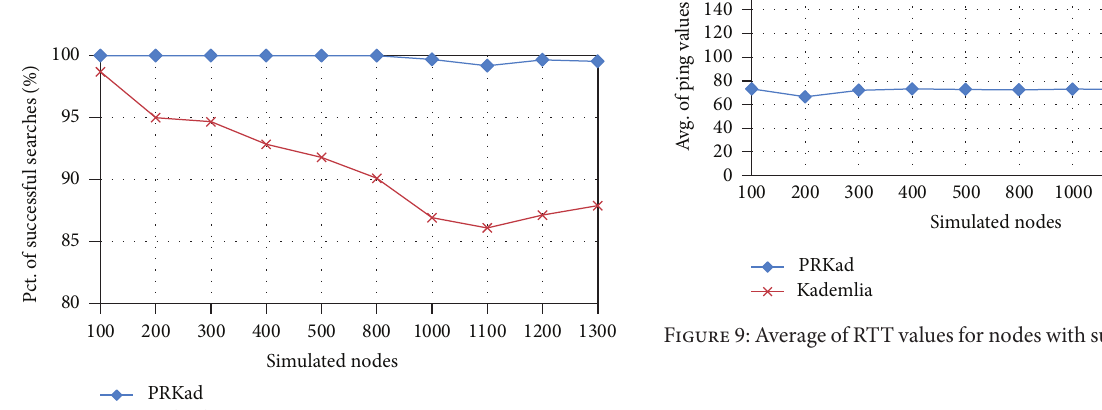
Figure 6: Illustration of a successful search.